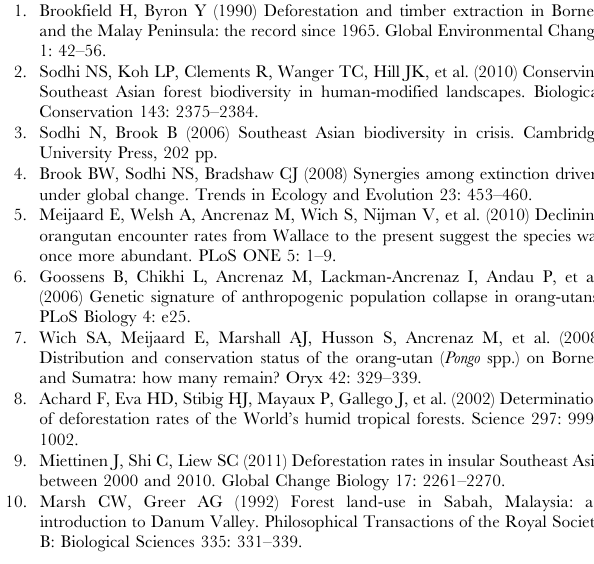
Figure S6 Per cent wet season precipitation delta maps under each CO 2 mitigation scenario. Per cent wet season precipitation delta maps at 2041, 2071 and 2100 relative to 2010 for Ref and Pol scenarios. (TIFF) Figure S7 Per cent dry season precipitation delta maps under each CO 2 mitigation scenario. Per cent dry season precipitation delta maps at 2041, 2071 and 2100 relative to 2010 for Ref and Pol scenarios. (TIFF) Figure S8 Degree Centigrade temperature delta maps under each CO 2 mitigation scenario. Degrees Centigrade temperature delta maps at 2041, 2071 and 2100 relative to 2010 for Ref and Pol scenarios. (TIFF) Table S1 Spatial predictors. Spatial predictors used to build the Species Distribution Models and notes on their processing. (DOC) Table S2 Land cover change predictors. Table of variables considered important predictors of land cover change. Table S3 Accuracy statistics for the random forest models of 2010 land-cover predictions. Prediction error rates were low for the most-widespread land-cover classes but high for the least-widespread classes (e.g., mangrove and cleared land) because they constituted less than 5% of the land